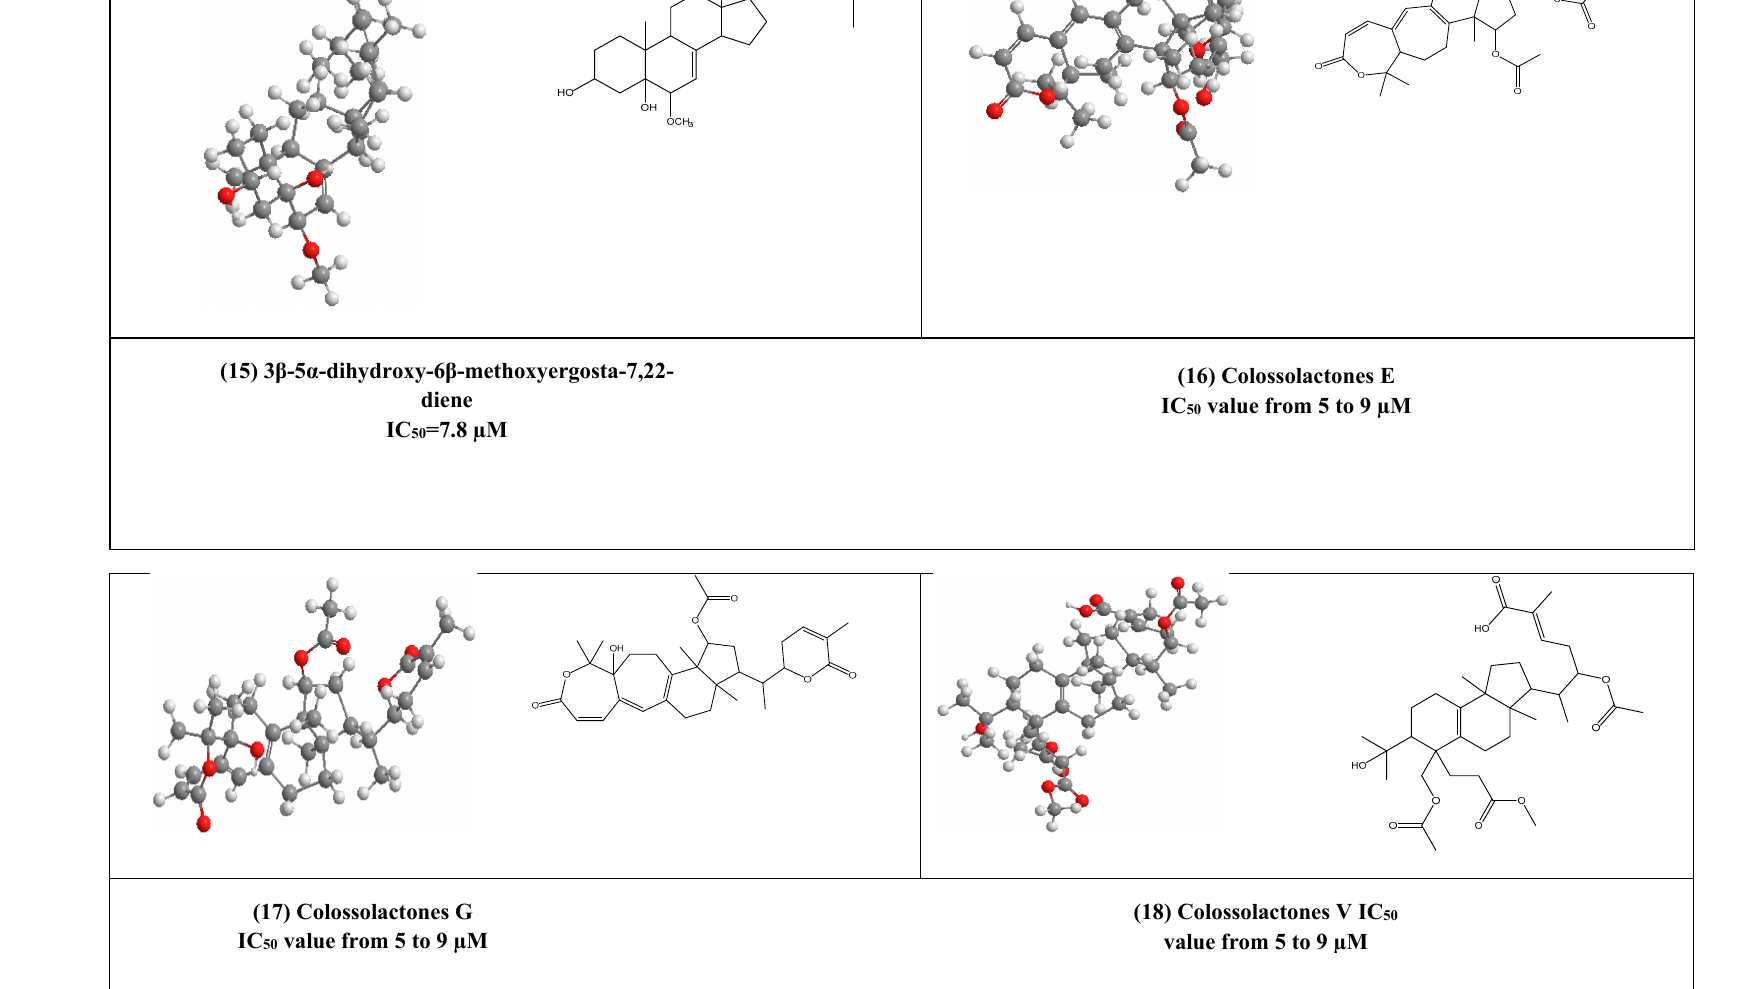
Figure 4. The 2D and 3D chemical structures of virus protease